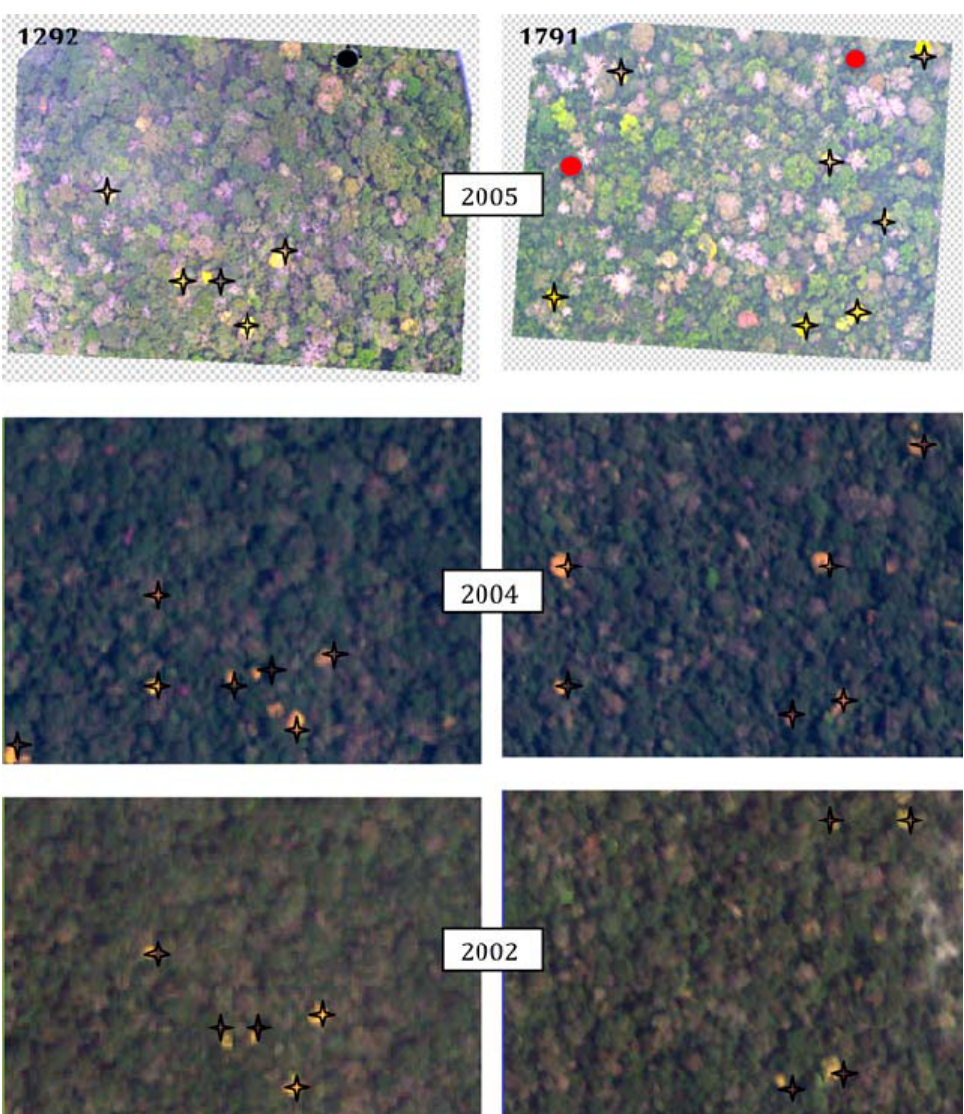
Figure 7. Comparison of Quickbird satellite images for 2002 and 2004 and the Smithsonian Tropical Research Institute’s aerial photography (1292 and 1791). Starts represent detected flowering trees (images and photos), black dots represent a tree with new leaves and red dots represent dead trees in 2005 that flowered in 2004 and